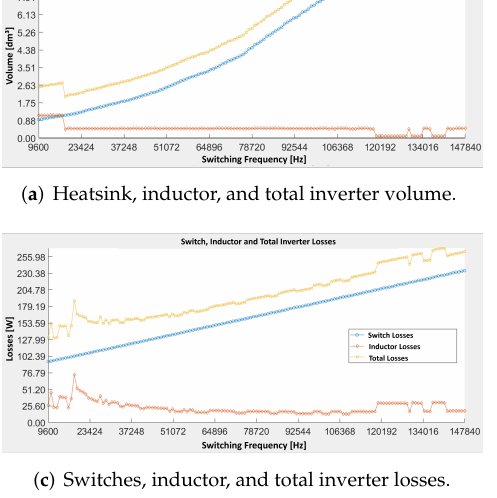
Figure 5. Inverter volume, weight, and loss